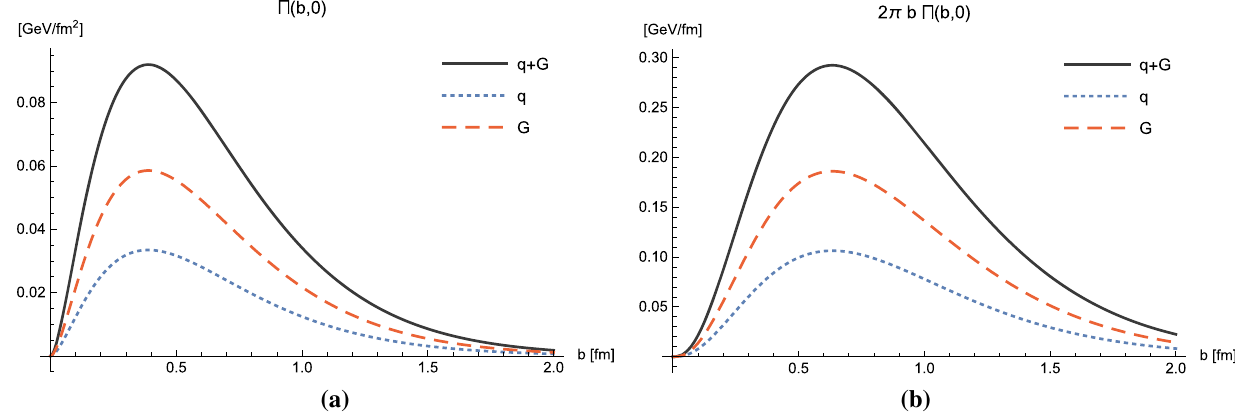
Fig. 15 Plots of the two-dimensional pressure anisotropy, a (cid:21)( b , 0 ) and b 2 π b (cid:21)( b , 0 ) , using the multipole model (11) with parameters given